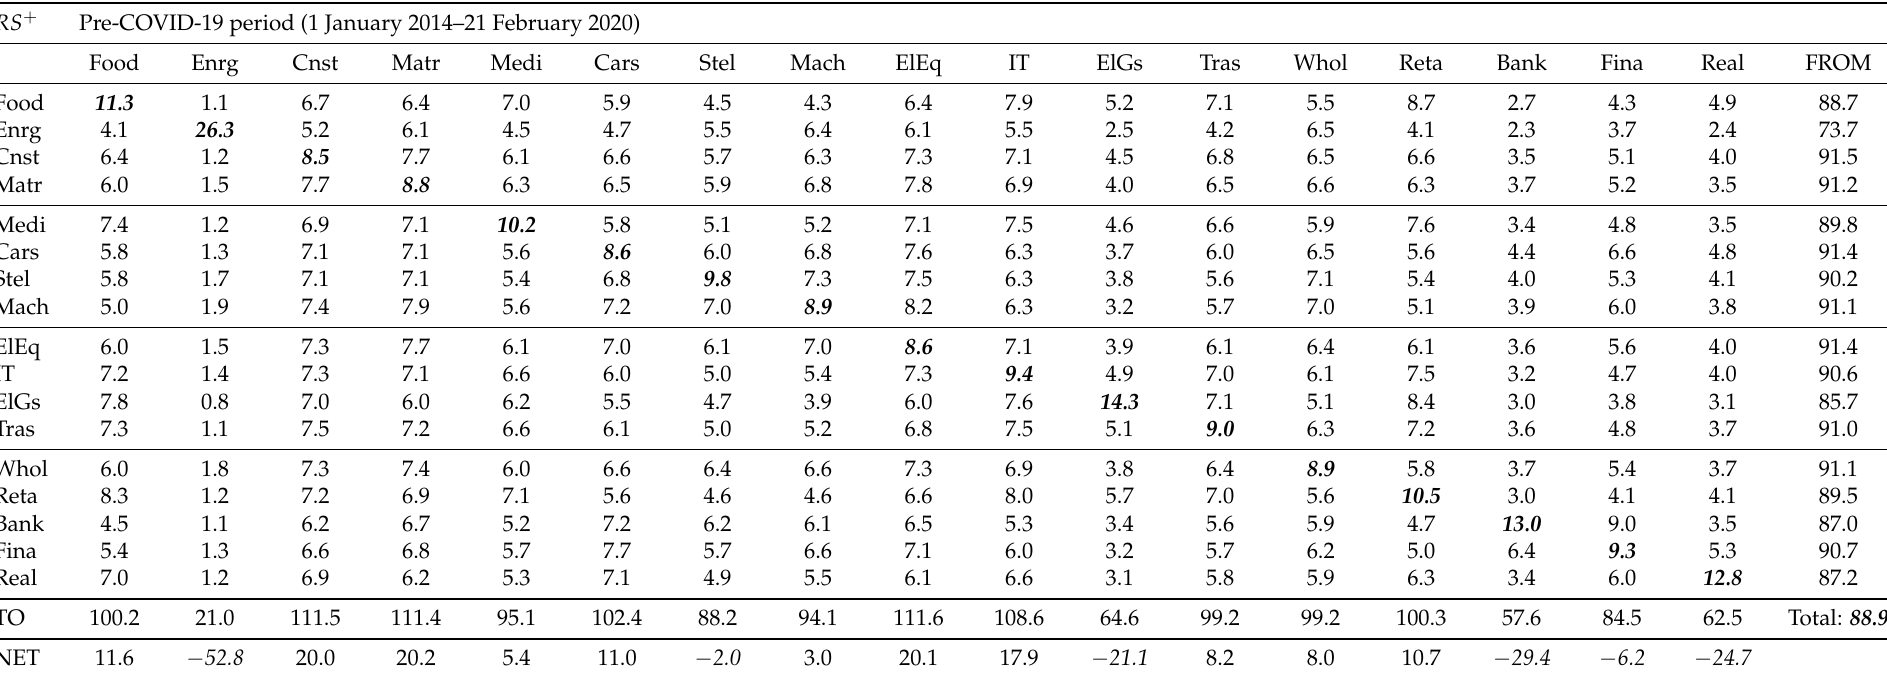
Table 5. Total spillover table based on positive realized semivariance during pre-COVID-19 and COVID-19